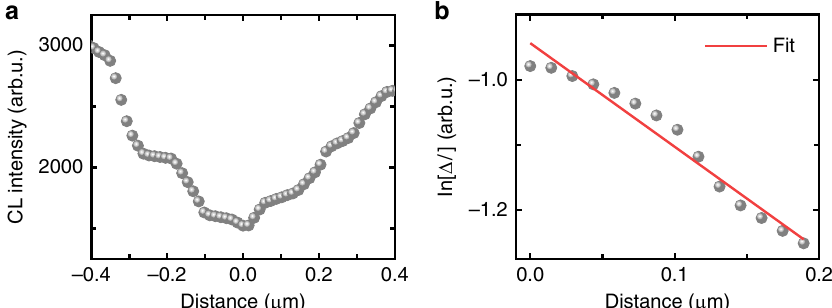
Fig. 5 Modeling of grain boundary recombination velocity. Extracted CL pro fi les across a GB ( a ), GB is located at zero position. Corresponding ln[ Δ I] plot for positive distance values with linear regression ( b ). The corresponding equation for the linear regression curve is ln[ Δ I ( x )] = − x /0.42 + ln(0.73/ (0.73 + 1)) where x is the